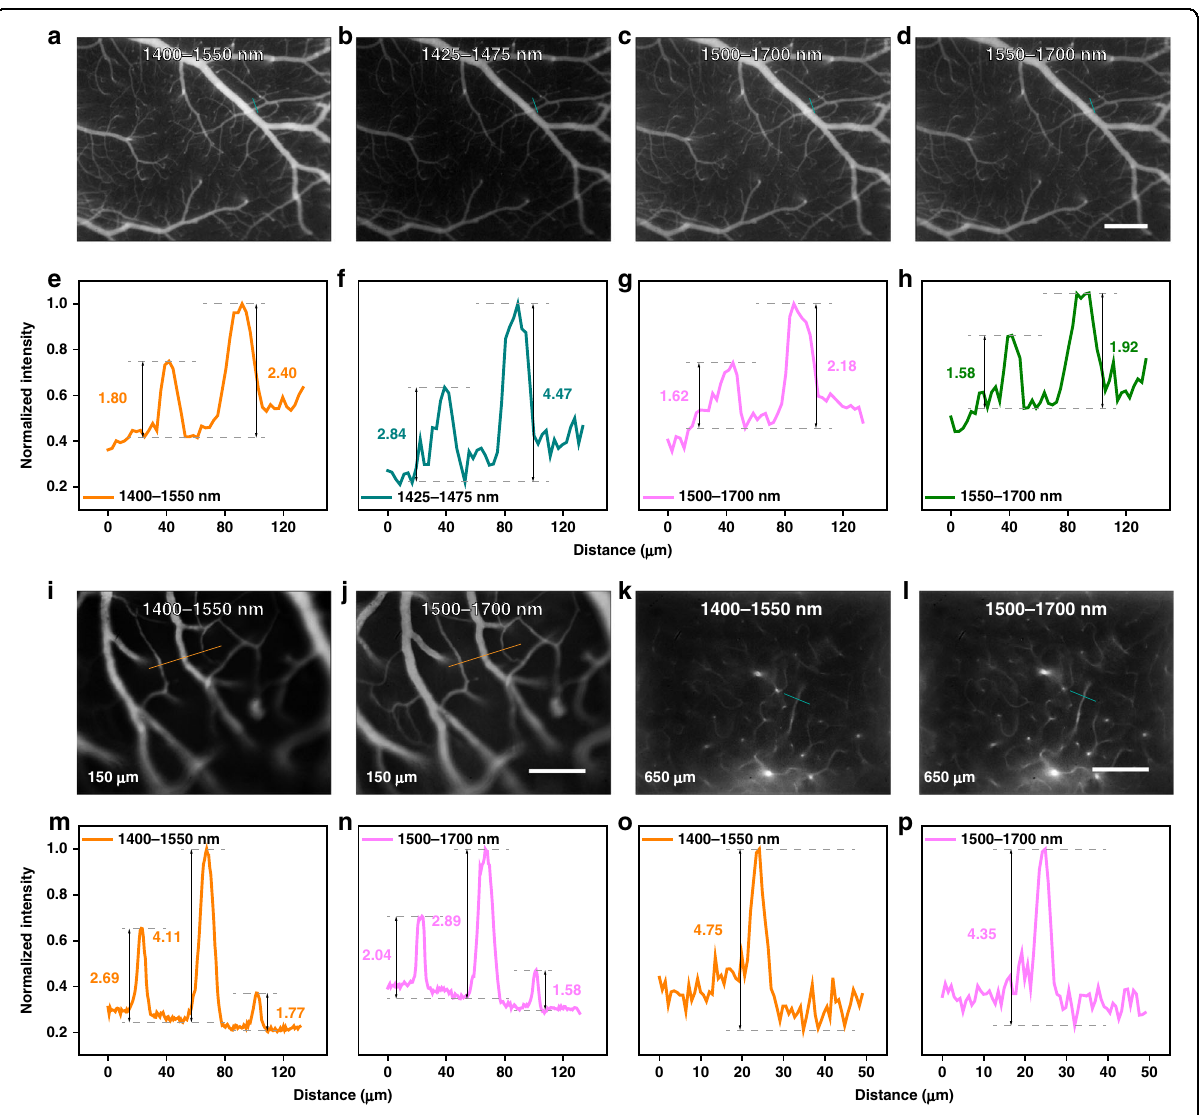
Fig. 7 In vivo fl uorescence wide- fi eld microscopic imaging beyond 1400 nm. The ×5 microscopic imaging of cerebral vasculature in the same mouse in ( a ) 1400 – 1550 nm, ( b ) 1425 – 1475 nm, ( c ) 1500 – 1700 nm, and ( d ) 1550 – 1700 nm. Scale bar: 300 μ m. e – h Cross-sectional fl uorescence intensity pro fi les along the indigo lines of the blood vessel in ( a – d ). The numbers show the SBRs. The ×25 microscopic imaging of cerebral vasculature in the same mouse at depth of 150 μ m in ( i ) 1400 – 1550 nm and ( j ) 1550 – 1700 nm. Scale bar: 100 μ m. The ×25 microscopic imaging of cerebral vasculature in the same mouse at depth of 650 μ m in ( k ) 1400 – 1550 nm and ( l ) 1550 – 1700 nm. Scale bar: 100 μ m. Cross-sectional fl uorescence intensity pro fi les along ( m , n ) the brown lines in ( i , j ) and ( o , p ) the indigo lines in ( k , l ). The numbers show the SBRs. q ×25 microscopic imaging of cerebral vasculature in 1400 – 1550 nm at various depths below the skull and the fl uorescence intensity analysis of the blood vessel at the depth of 900 μ m (the brown line). The brown arrows show the deep and tiny capillaries. Scale bar: 100 μ